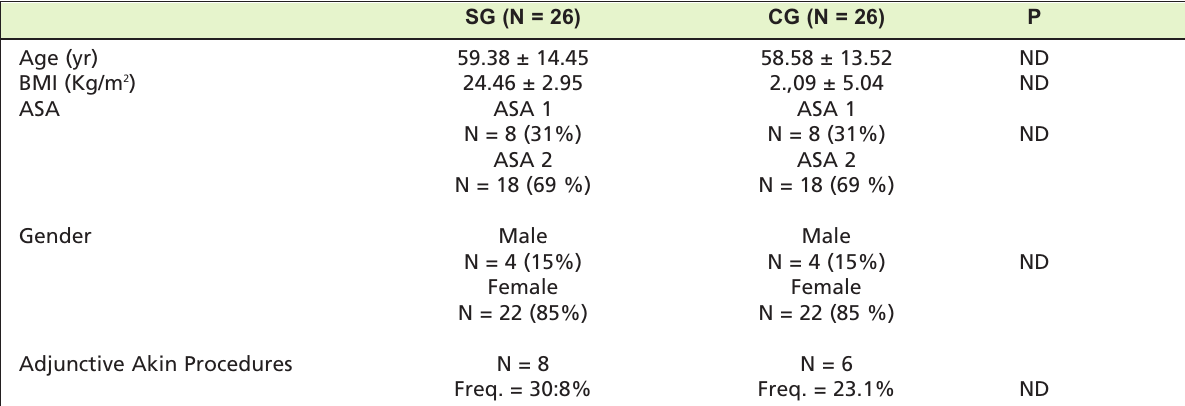
Patients characteristics Table I: